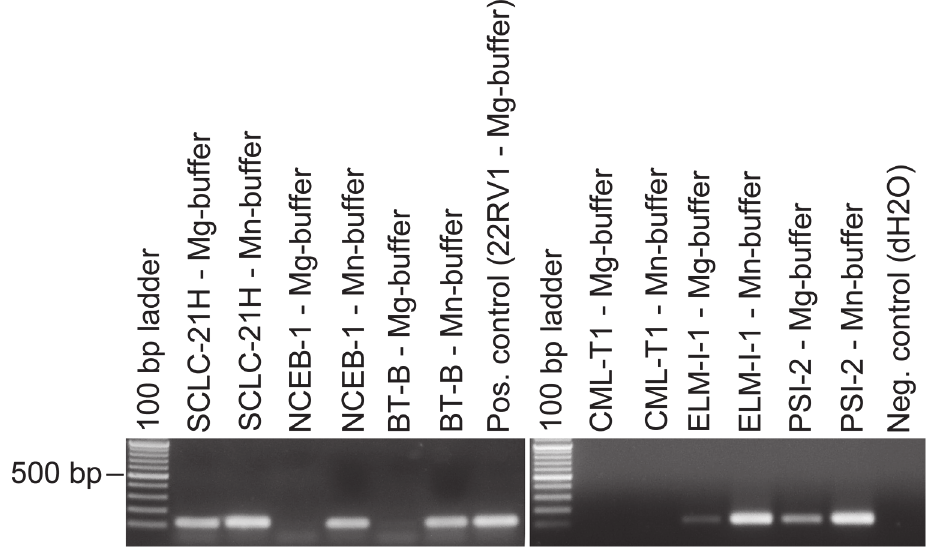
Fig 6. Detection of RT activity in human and mouse (ELM-I-1 and PSI-2) cell culture supernatants by PERT assay. The assay was carried out applying two different buffers containing MgCl 2 or MnCl 2 , respectively. The Mn 2+ -buffer was more sensitive in most cases, indicating that the contaminating viruses presumably belong to the Mn 2+ -dependent C-type retroviruses. The CML-T1 cell line was MLV-PCR positive due to contamination of the genomic DNA with mouse derived DNA. The size of the MS2 PCR product is 112 bp.